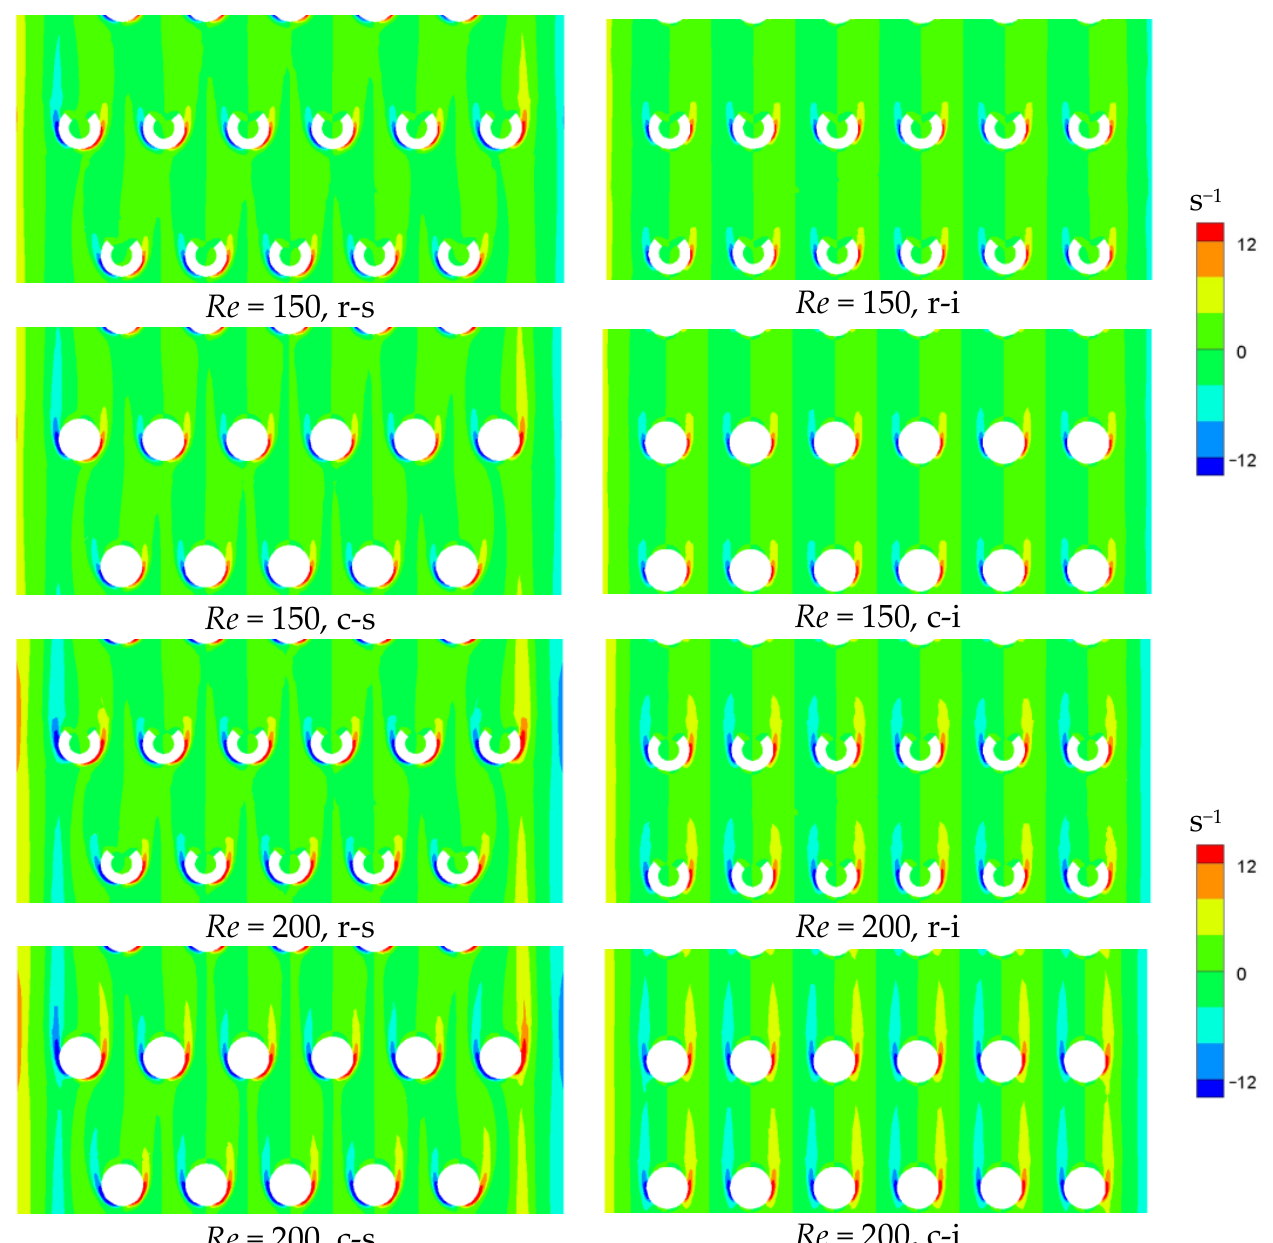
Figure 9. Vorticity distribution in four types of micro-pin-fin array at different Re . At low Reynolds numbers, the vorticity region already appears on both sides of the micro-pin-fins, and diffuses mainly along the lateral direction. With the increase of Re , the vorticity intensifies. The main direction of diffusion of vorticity gradually changes from lateral to streamwise, and the high vorticity region expands further downstream. At a given Reynolds number, the maximum vorticity intensity in the staggered micro- pin-fin array is greater than that of the in-line array, but the downstream extension of vorticity bands is shorter. The reason is that the velocity gradient in the staggered array is larger, but the lateral velocity in the flow has hindered the streamwise diffusion of vorticity. For a given layout, the maximum vorticity intensity in the ring-shaped fin array is slightly higher than that of the circular one, while the downstream diffusion ability is slightly lower. This difference becomes more notable with the increase of Re